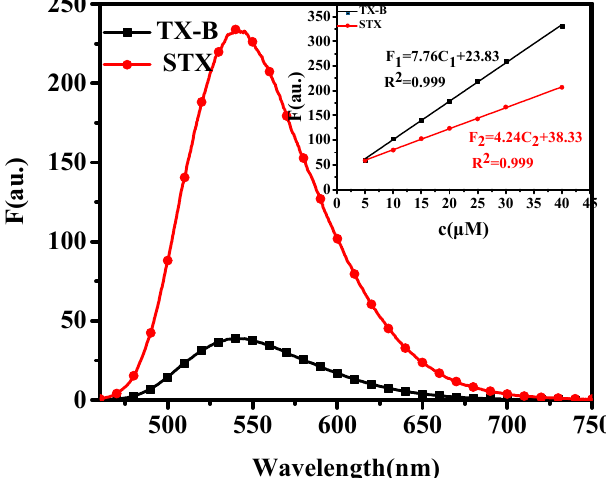
Figure 3. Fluorescence emission spectra ( λ ex : 450 nm, λ em : 540 nm) of TX-B and STX after being extracted with acetone from the polymer prepared by photopolymerization of HDDA in the presence of PIs ([TX-B] = 3 × 10 − 5 mol g − 1 , [STX] = 3 × 10 − 5 mol g − 1 ) under argon. [STX] refers to the molar concentration of the ATX moiety. (Inset: Correlation of the fluorescence intensity (at 540 nm) with different concentrations of TX-B and STX in acetone solution).